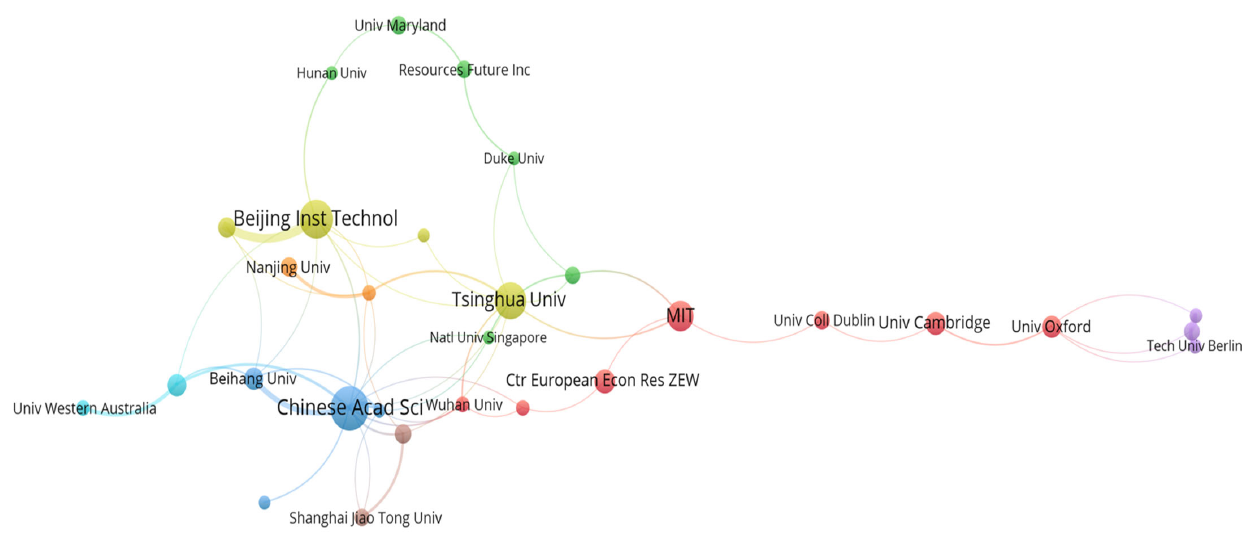
Figure 5. Co ‐ operation of institutions. Figure 5. Co-operation of institutions.